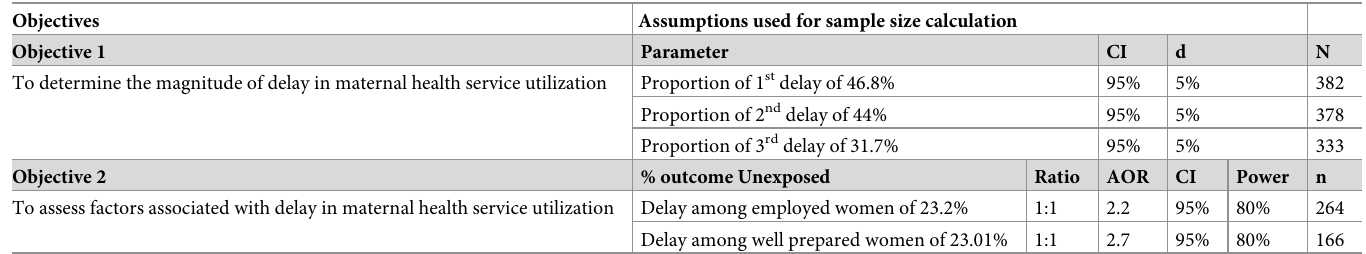
Table 1. Sample size calculation for respective